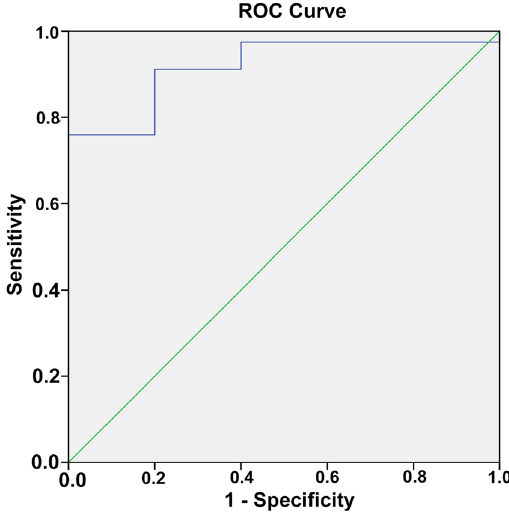
Figure 4. The ROC curve of NIRF image using ICG based on the SBRs.